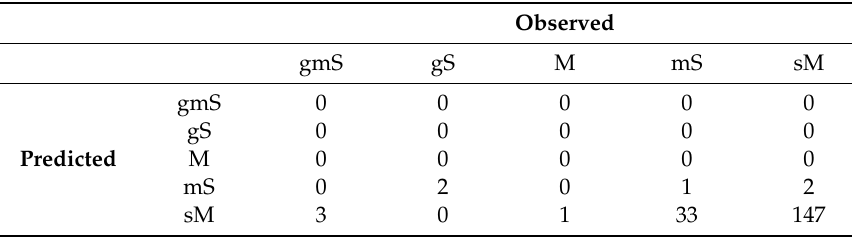
Table A6. Categorical simplified Folk S-LOO CV error